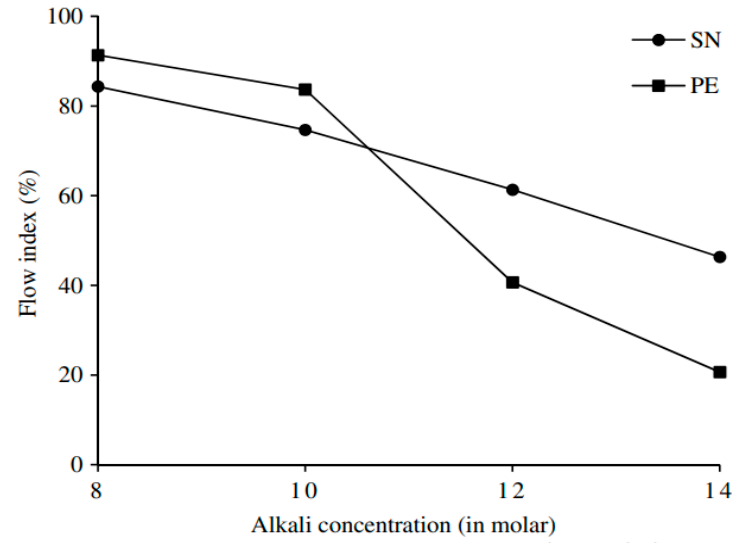
Figure 11. E ff ect of alkaline concentration on setting time Figure 11. Effect of alkaline concentration on setting time [110].